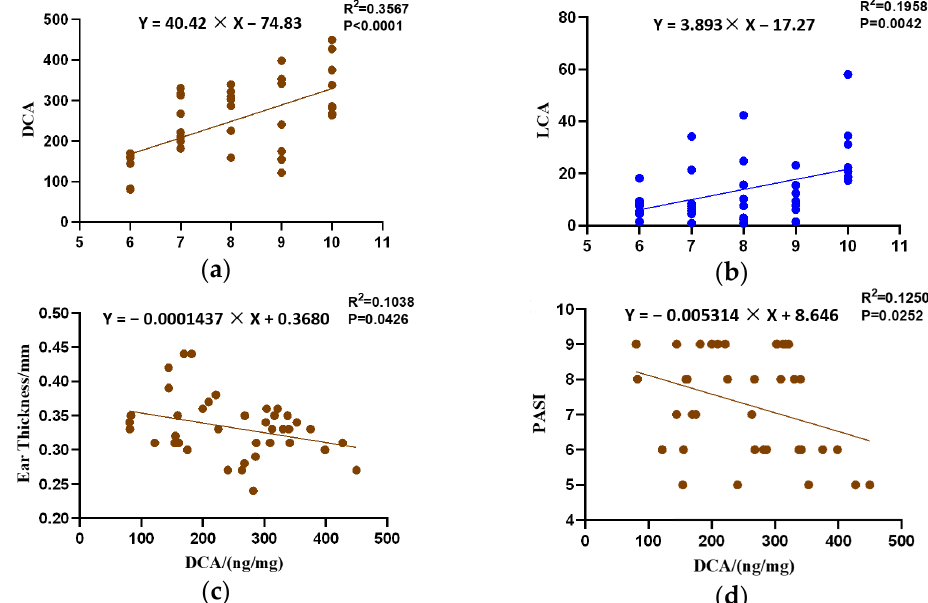
Figure 6. Quantitative relationships between the colonic bile acid concentrations and psoriasis indicators. The interdependent quantitative relationships between the CCFM683 doses and colonic ( a ) DCA and ( b ) LCA concentrations. Quantitative relationships between the DCA concentration and ( c ) ear thickness and ( d ) cumulative score.